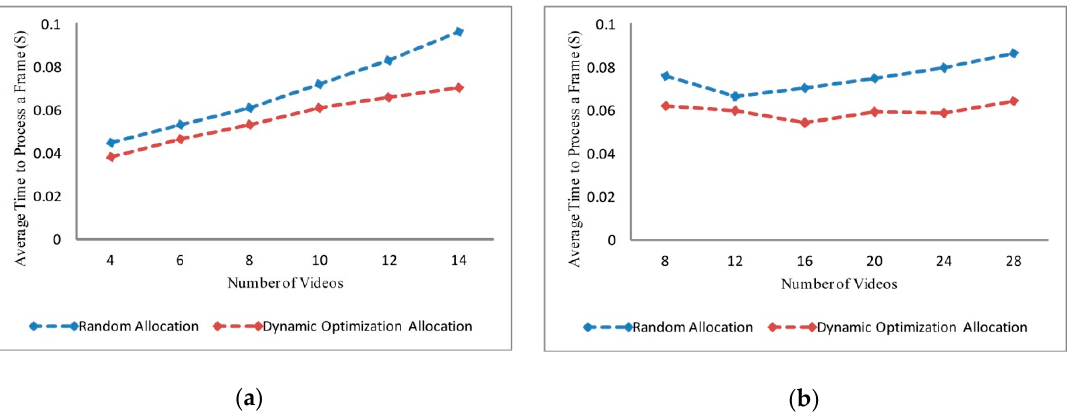
Figure 8. ( a ) Comparison of the average time for processing each frame when performing random allocation and dynamic optimization allocation;( b )comparison of the average time of processing each frame when performing random allocation and dynamic optimization allocation in the case of four agents.